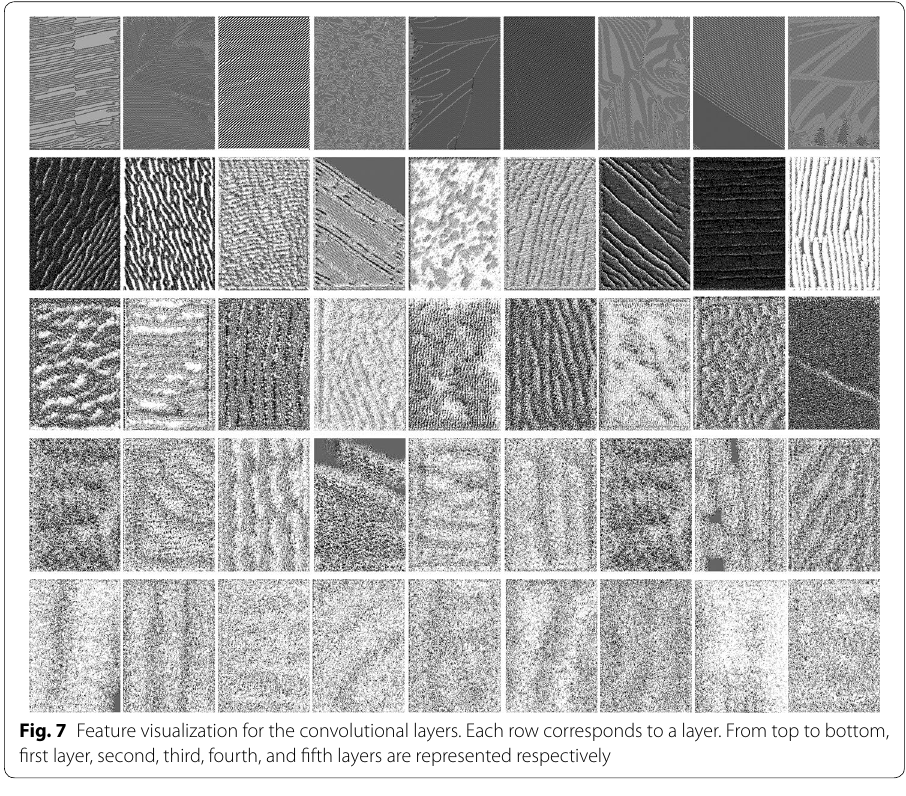
Fig. 7 Feature visualization for the convolutional layers. Each row corresponds to a layer. From top to bottom, first layer, second, third, fourth, and fifth layers are represented respectively